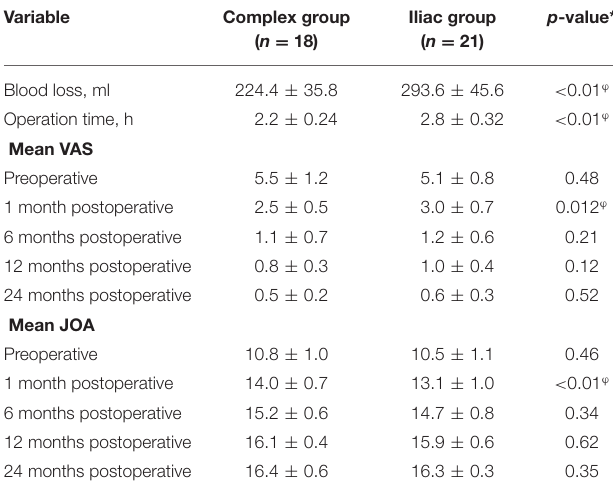
TABLE 2 | Comparison of surgical characteristics and outcome measures between two